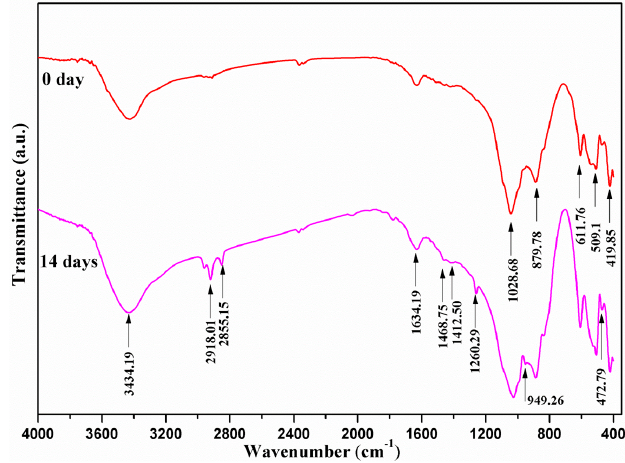
Figure 8. Fourier transform infrared spectrums of the scaffolds with 20 wt % CaSiO 3 before and after soaking in SBF.